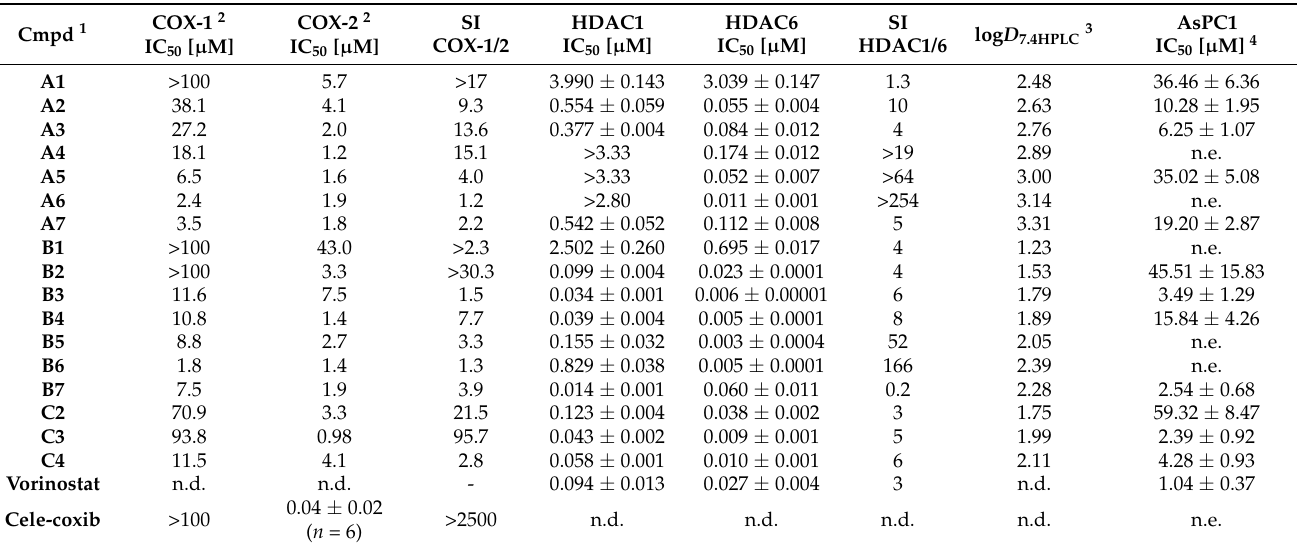
Table 2. Inhibitory activity against COX-1, COX-2, HDAC1, HDAC6, and AsPC1 cells as well as log D values of A1–A7 , B1–B7, and C2–C4